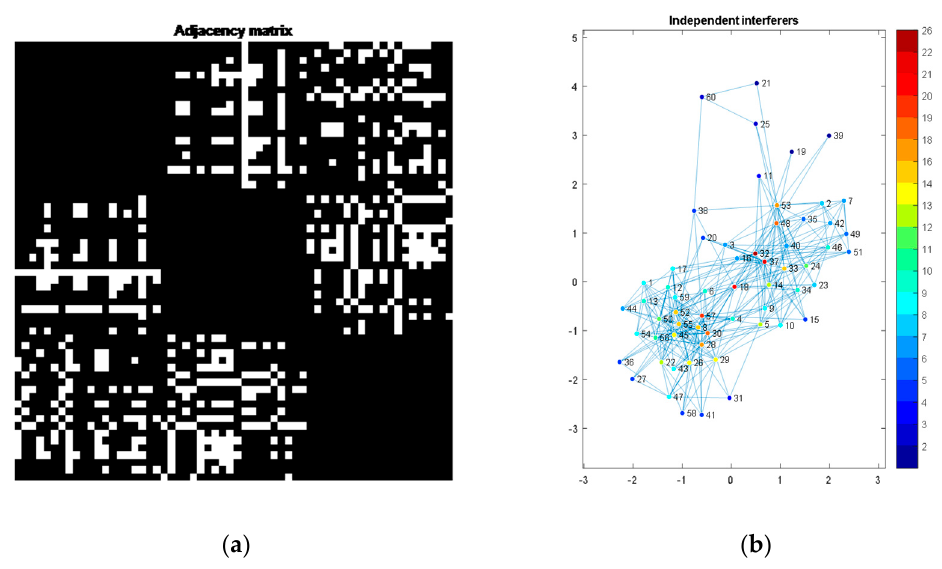
Figure 5. (a) Adjacency Matrix (b) Independent Interferers Figure 5. ( a ) Adjacency Matrix ( b ) Independent